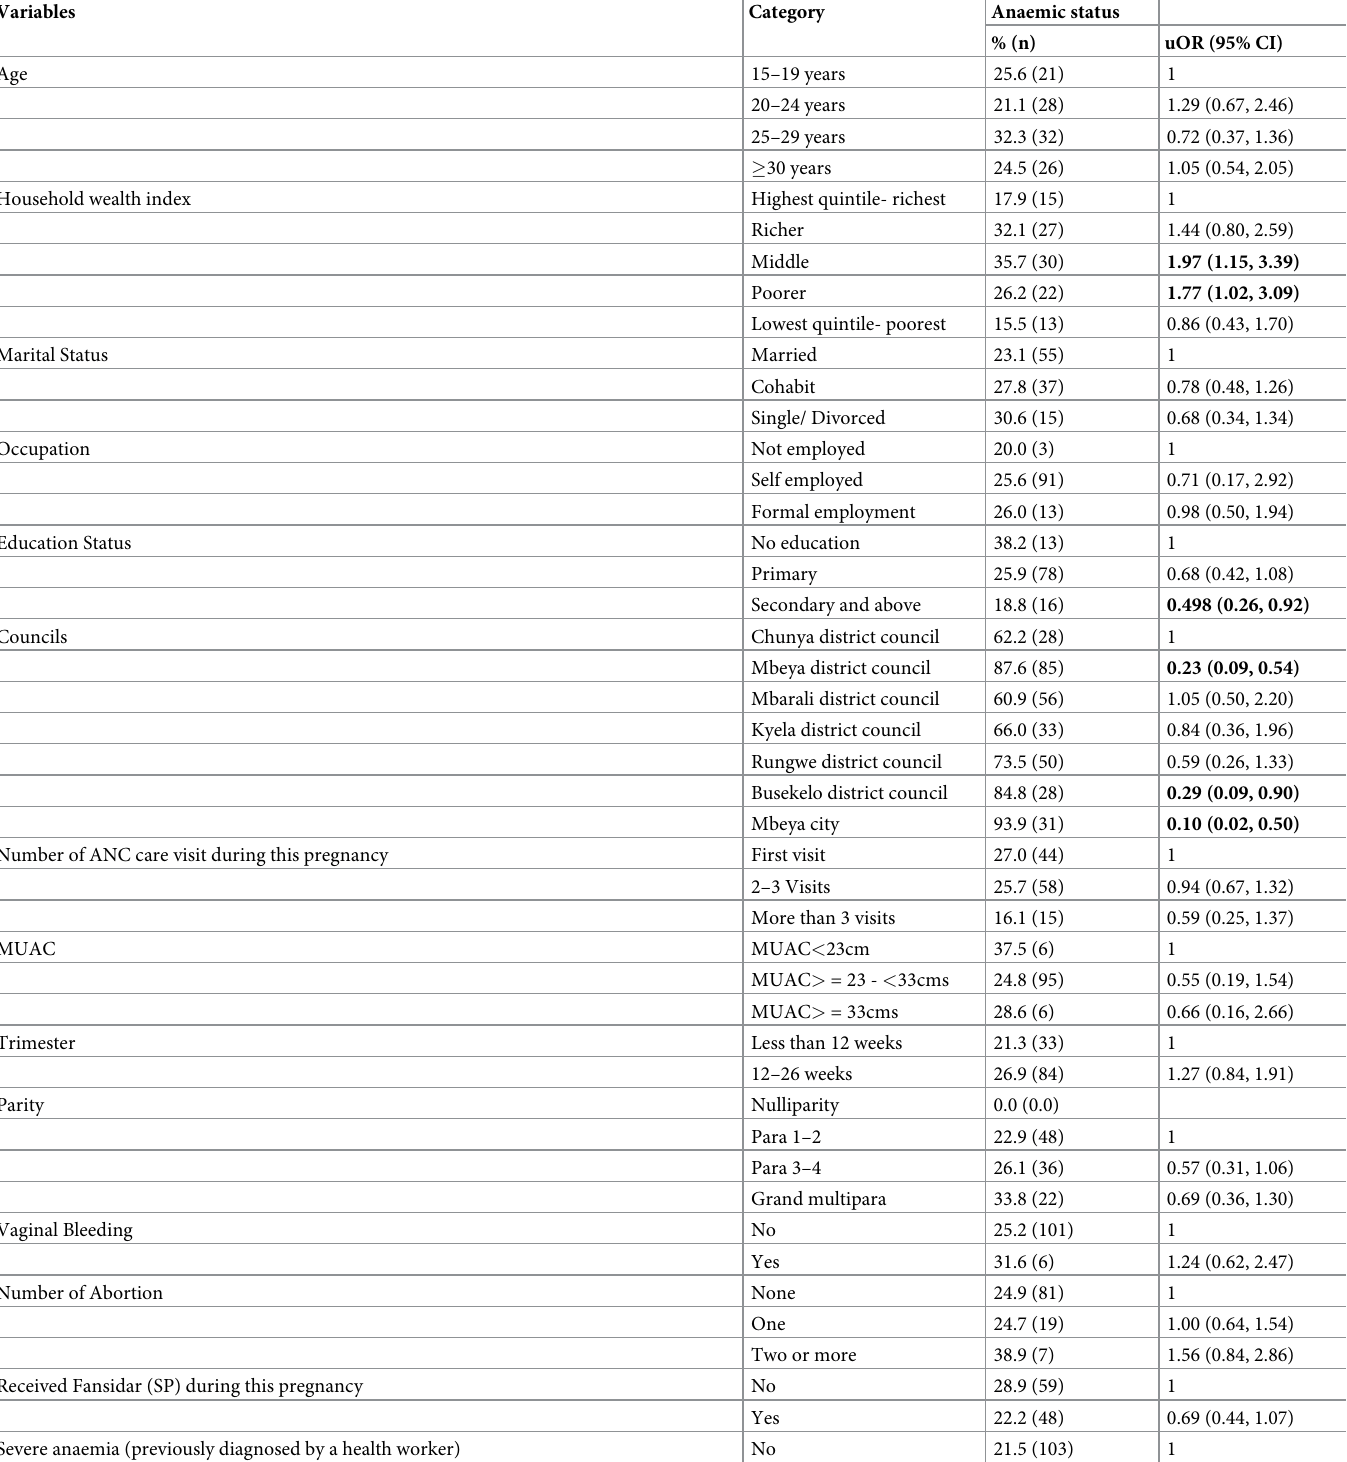
Table 3. Univariate logistic regression of anaemia status with socio-demographic, reproductive health, and nutrition characteristics among pregnant women attending Antenatal clinics in Mbeya, Tanzania (n =